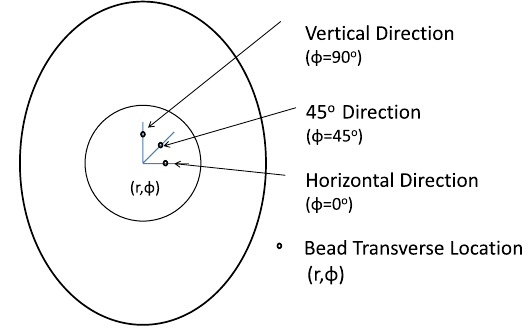
FIG. 18. Bead-pull measurements were performed for each mode at different transverse locations at three azimuthal angles — horizontal, vertical, and 45°